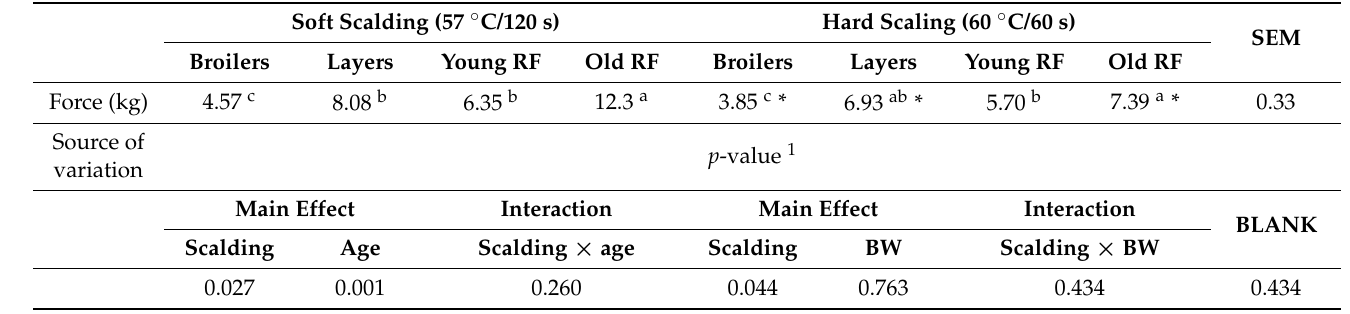
Table 4. Effects of soft and hard scalding on skin tensile force of different breeds of